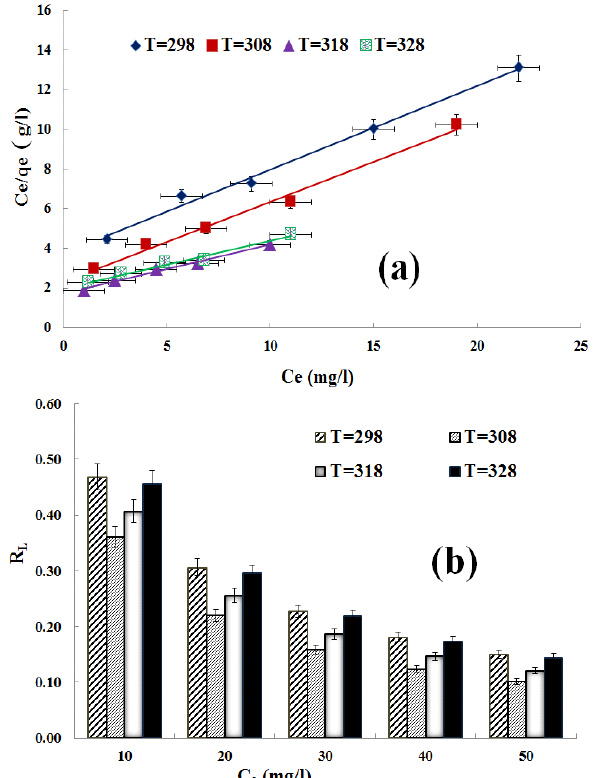
Fig. 4. (a) Langmuir isotherm, and (b) separation factor for adsorption of mercury ions on Ghezeljeh nanoclay.